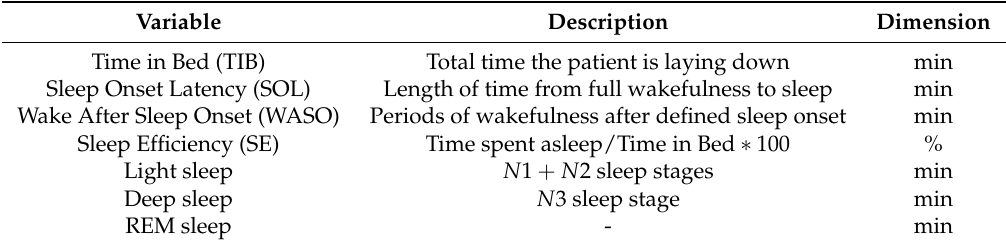
Table 1. Summary of the features of interest for our